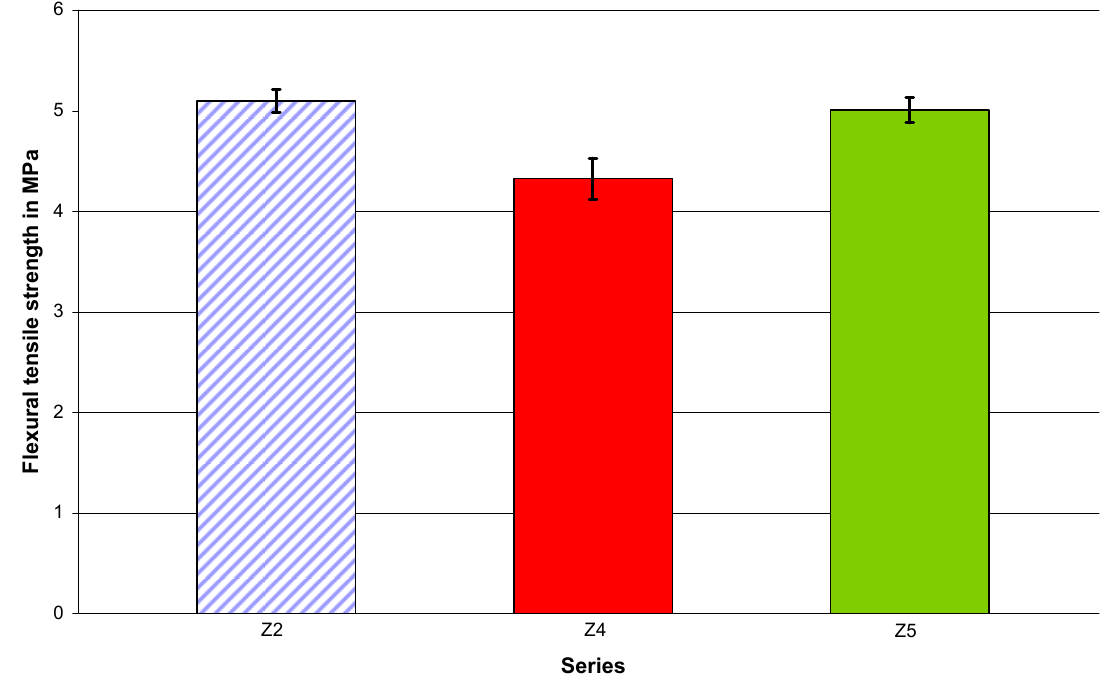
Figure 10. Results of the flexural tensile strength test for the concretes with the scattered reinforcement in the form of PET fibres (length 62 mm), polypropylene fibres, and steel fibres.